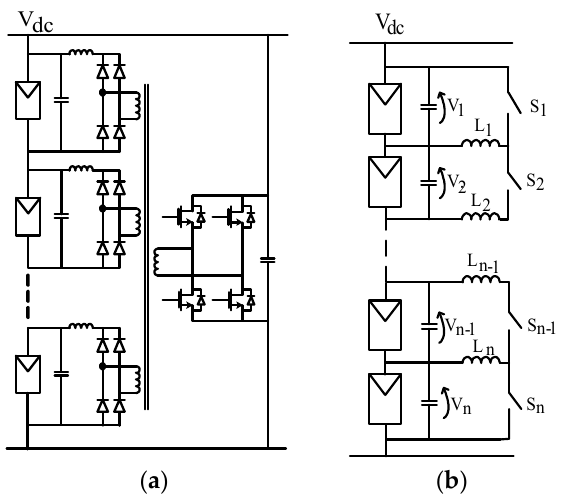
Figure 17. GCC implementation by multi-stage choppers: Type A ( a ); Type B ( b ). The volt–sec balance dictates that the average voltage across the k th PV module, V k = D’ k V out , relates to the dc bus voltage, V out , and the off-duty cycle, D’ k , of the switch S k . Fine- tuning the duty cycle, D’ k , the voltage across each module in the string can be individually adjusted to its true MPP.